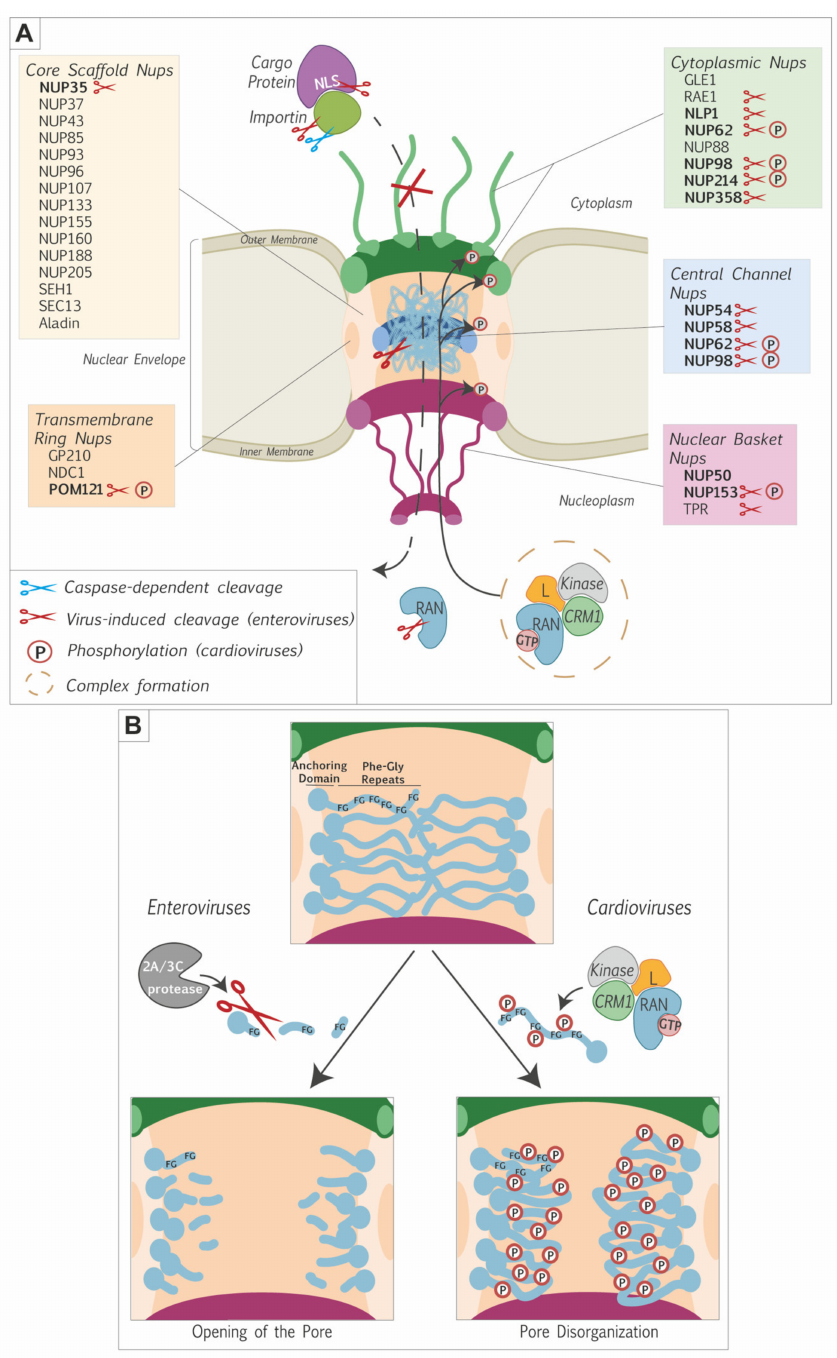
Figure 2. Picornavirus-induced alteration of the nuclear pore complex. ( A ) Illustration of the NPC showing alterations triggered by picornaviruses. The proteins forming the different nuclear pore components and some soluble phase proteins are indicated. FG-nucleoporins are in bold characters. Alterations triggered by picornaviruses are depicted as follows. Blue scissors: caspase-dependent degradation (e.g., importins); Red scissors: virus-dependent cleavage; P: phosphorylation. The model proposed to account for NUP phosphorylation by cardioviruses is illustrated: a complex formed between the L protein, RAN and exportins would recruit kinases (e.g., ERK1/2 and p38) to the NPC, where these kinases would induce the phosphorylation of FG-nucleoporins. ( B ) Zoom on FG-nucleoporins molecular modifications by picornaviruses. Enteroviruses use their 2A pro and 3C pro to cleave the FG domains, thereby inducing an opening of the pore. Cardioviruses use their L protein to trigger the phosphorylation of the FG-rich domains of FG-nucleoporins, thereby inducing disorganization of the